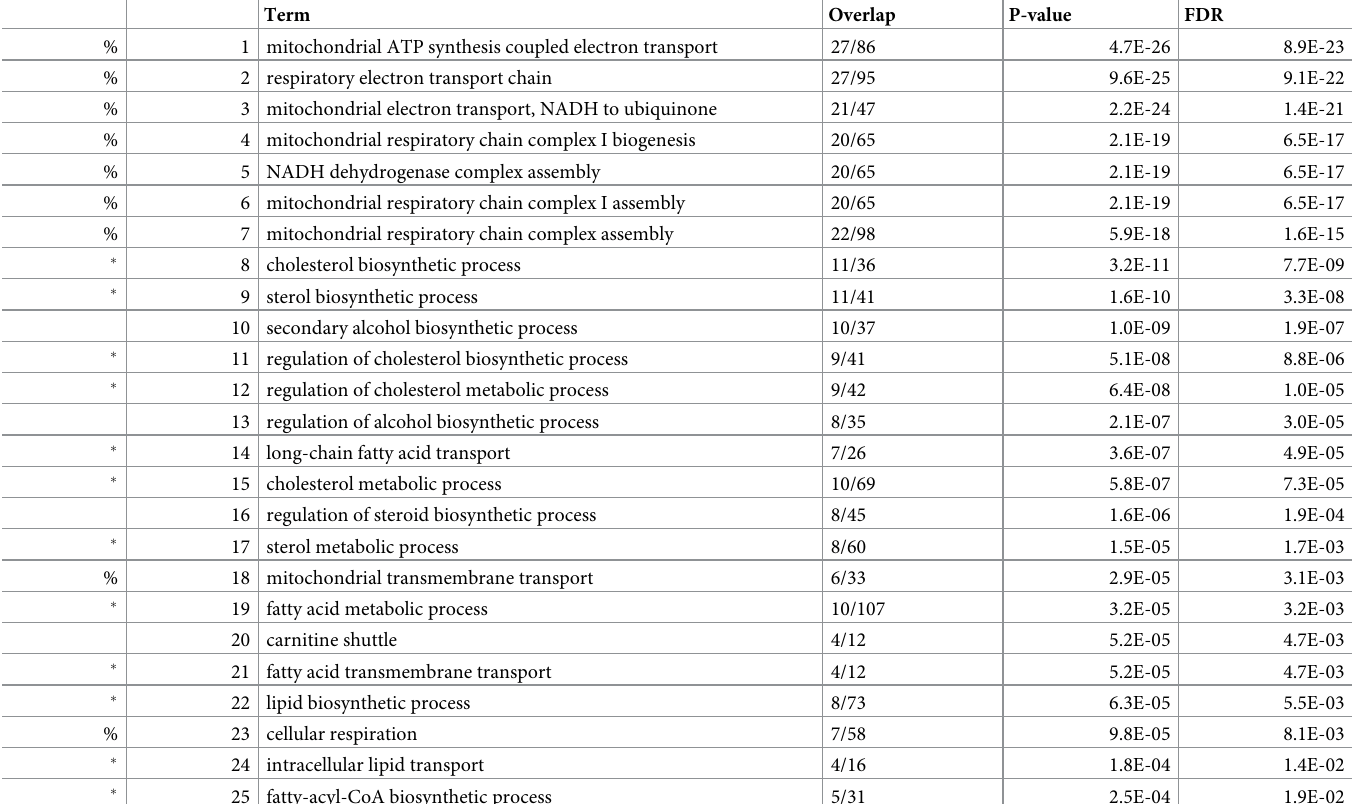
Table 5. Top 25 biological processes potentially regulated by the 374 DEGs in Holstein cows.